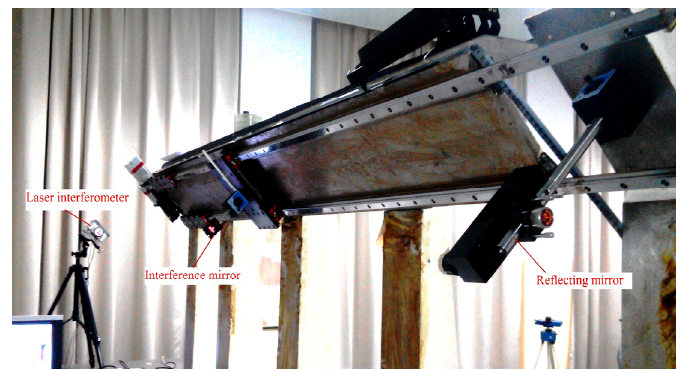
Figure 8. Straightness motion error experiment.